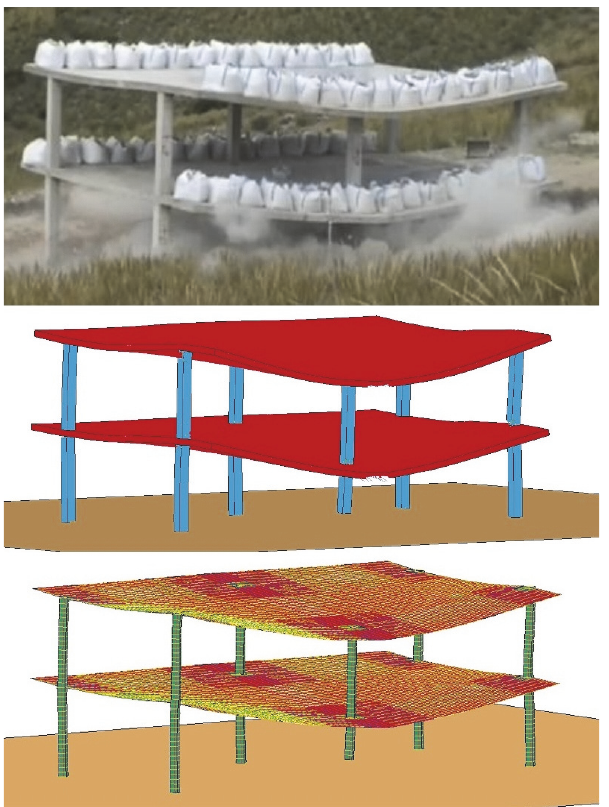
Figure 11: Comparison between test, continuum model, and struc- tural model at 1.1 s after column